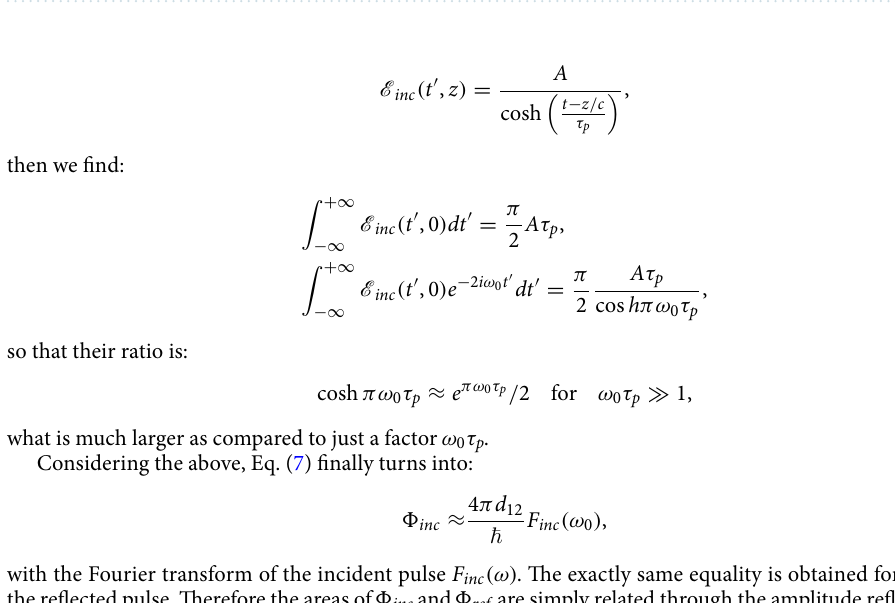
Figure 3. Evolution of the pulse area (cid:31) in an amplifier medium from the initial value � 0 = 0.05 π to the limit cycle (red curve ABC ); r (ω 0 ) = 0.7 , | α | = 12 cm − mathw